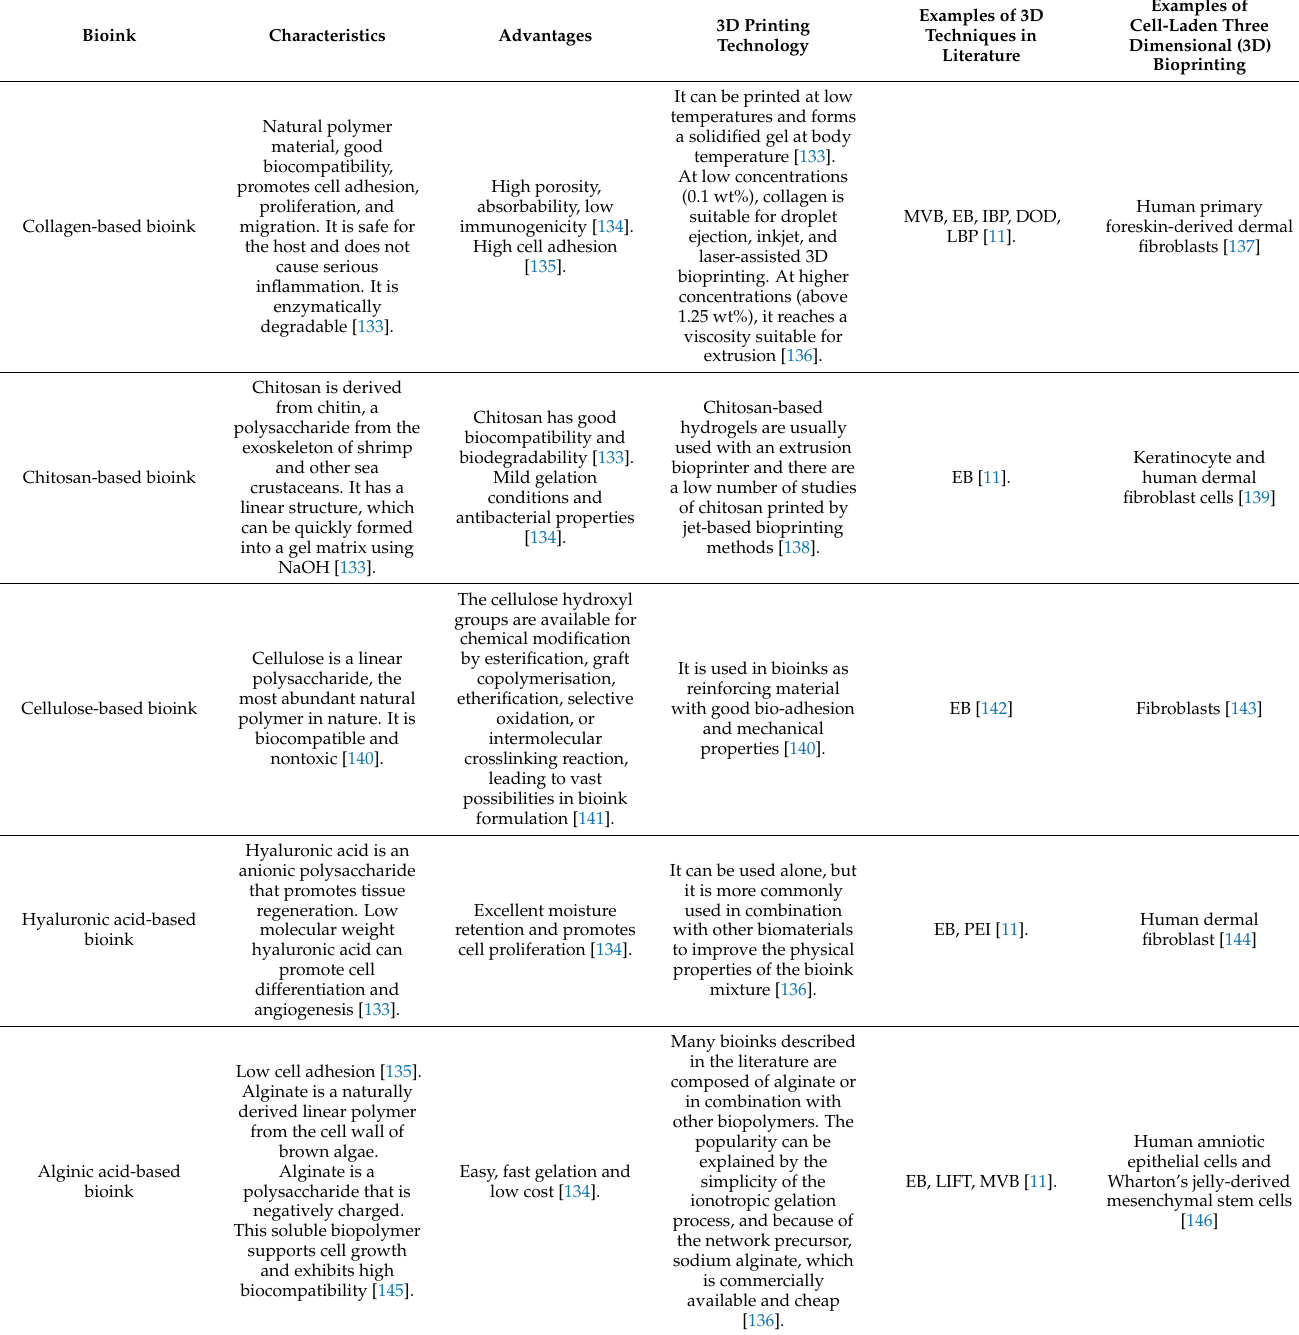
Table 1. Characteristics, advantages and 3D printing technologies used with collagen, chitosan, cellulose, hyaluronic acid, and alginate-based